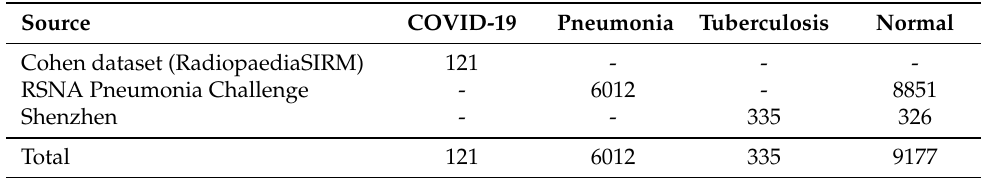
Table 1. Building the dataset of COVID-19 X-ray